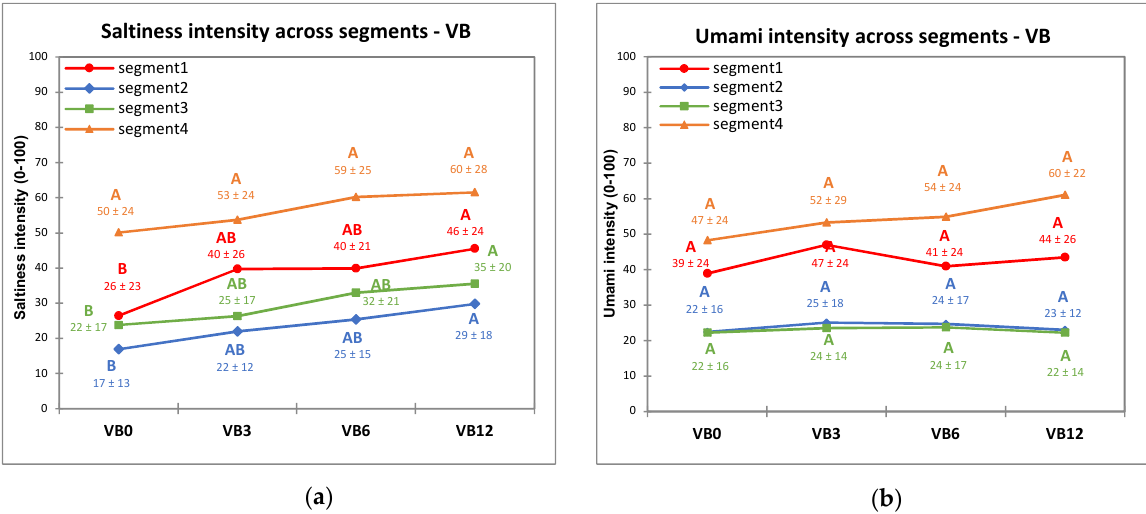
Figure 4. Taste intensity rating in vegetable broth samples (mean intensity rating ± SD), (VB; 0–12 g/L added sodium chloride) for: saltiness ( a ) and umami ( b ) across the four segments. Different letters indicate significant differences ( p < 0.05) from Tukey’s HSD test across concentrations within each